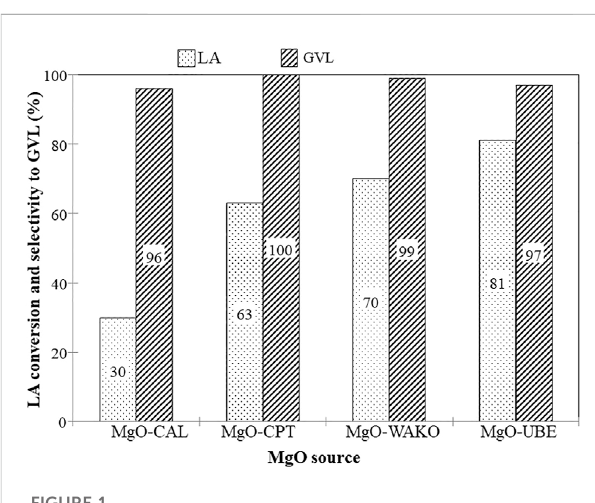
FIGURE 1 LA hydrogenation activity of different Mgo catalysts